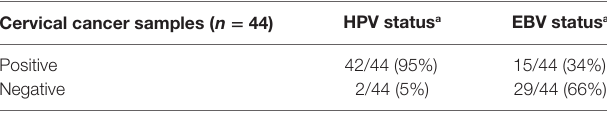
TaBle 2 | Epstein–Barr virus (EBV) and high-risk HPVs detection in human cervical